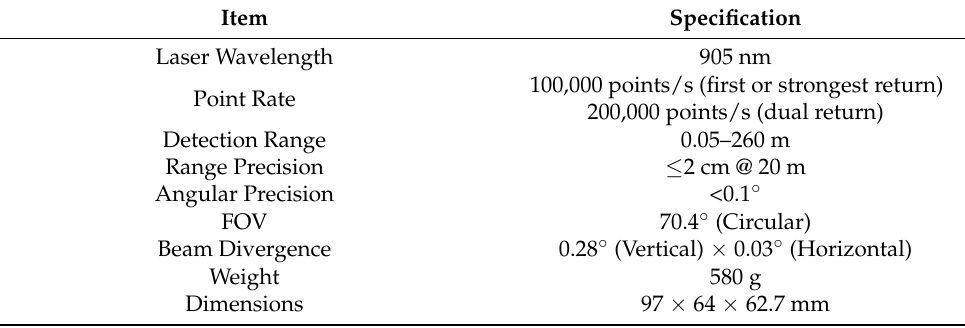
Table 2. The main specifications of Mid-70